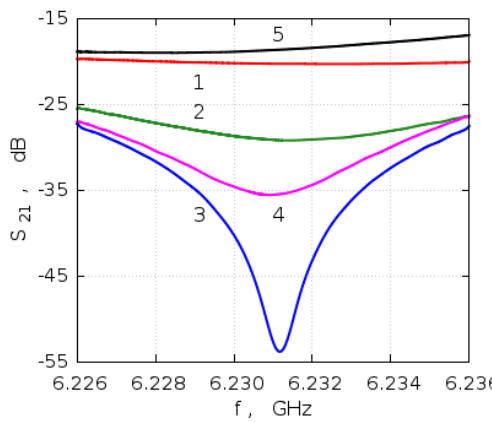
Figure 7: Time curves showing the recombination